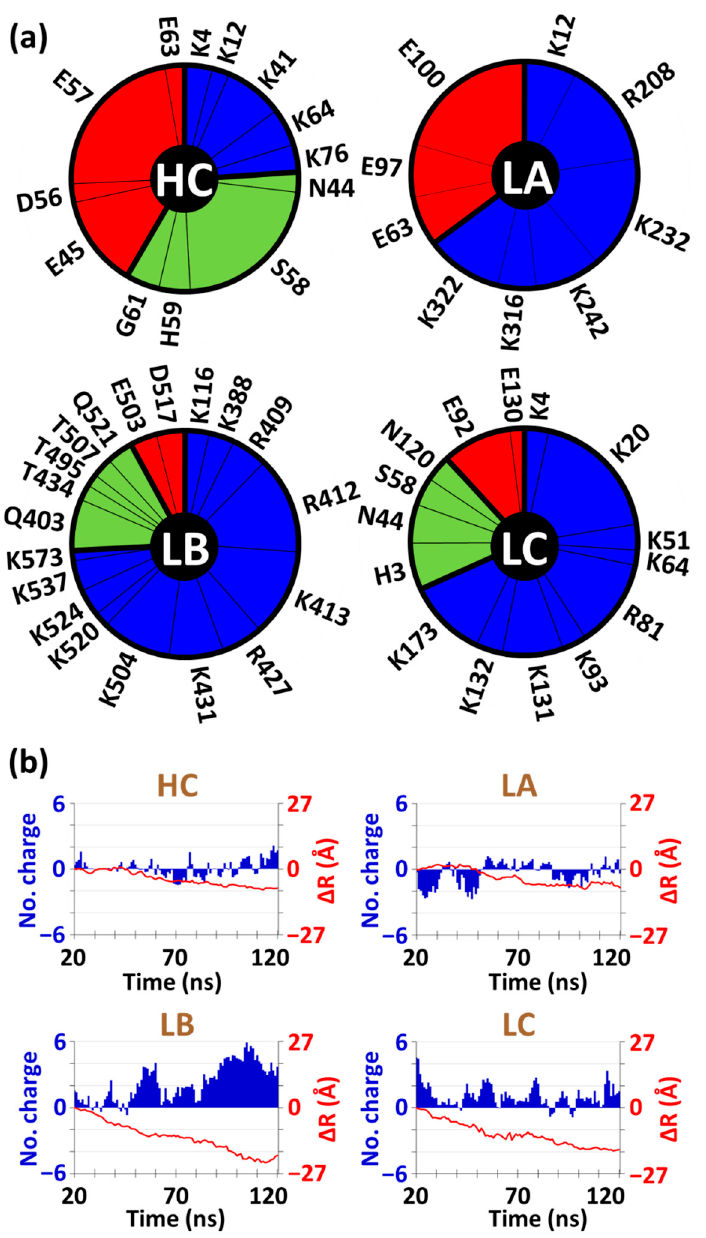
Figure 7. The BSA-polymer chain interactions for models HC, LA, LB, and LC, (see Figure 2 for details about the different models) by which the BSA anchors or penetrates to the surface. ( a ) The percentages of electrostatic interactions between positively charged amino acids (color: blue), negatively charged amino acids (color: red) within the BSA and the polymer chains. The percentage hydrogen bond interactions between uncharged amino acids (color: green) within the BSA and the polymer chains. The percentages were computed from the percentage values that are presented in Figure S9. ( b ) The number of positively and negatively charged amino acids (blue graphs), and the distance difference between the amino acids and the polymer chains (red graphs) along the MD simulations (20–120 ns). The large number of positively charged amino acids in models LB and LC indicate that the BSA penetrates the low-density surface (two bottom graphs).